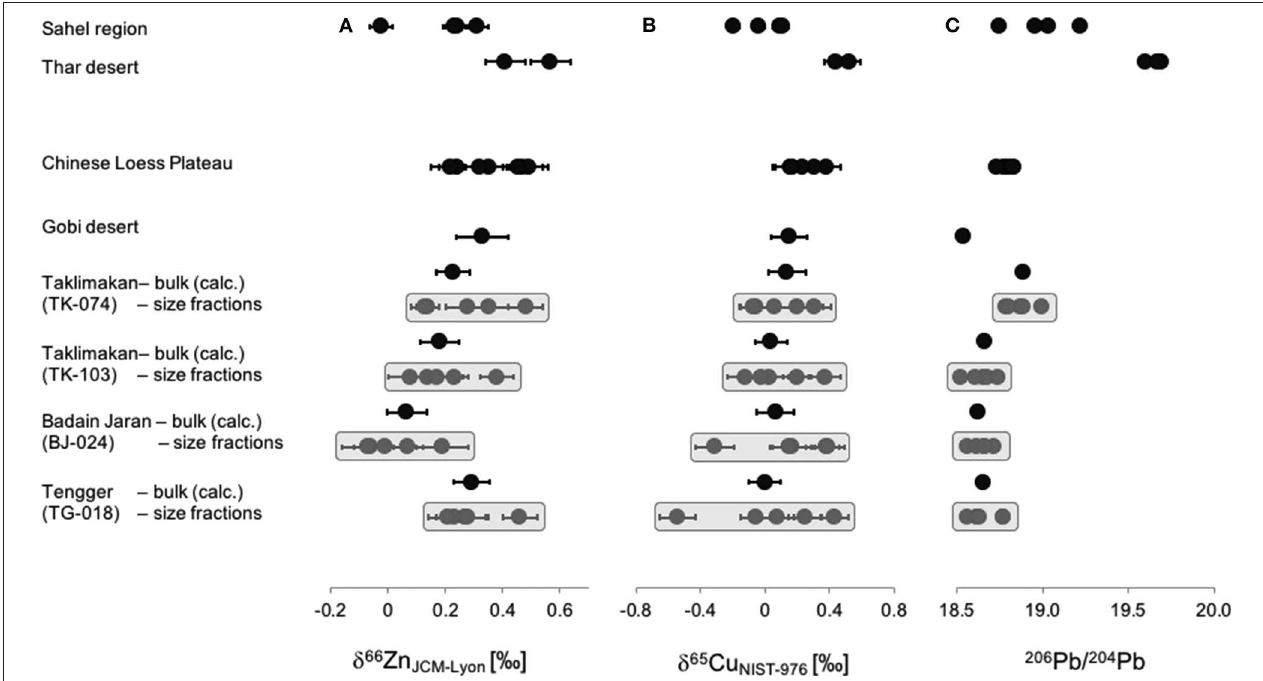
FIGURE 2 | Isotope ratios of Zn ( A , expressed as δ 66 Zn JMC − Lyon ), Cu ( B , expressed as δ 65 Cu NIST − 976 ), and Pb ( C , expressed as 206 Pb/ 204 Pb) in the mineral dust samples studied in this work. Samples from the Taklimakan, Tengger and Badain Jaran deserts show the measured isotope ratios of the individual size fractions (gray shadows) as well as of the calculated bulk value. The bulk isotopic composition of the elements was calculated using mass balance, i.e., δ X bulk = Σ δ X i x f i or 206 Pb/ 204 Pb = Σ 206 Pb/ 204 Pb i x f i , where i = size fraction, and f i = abundance of the fraction i with respect to the bulk.